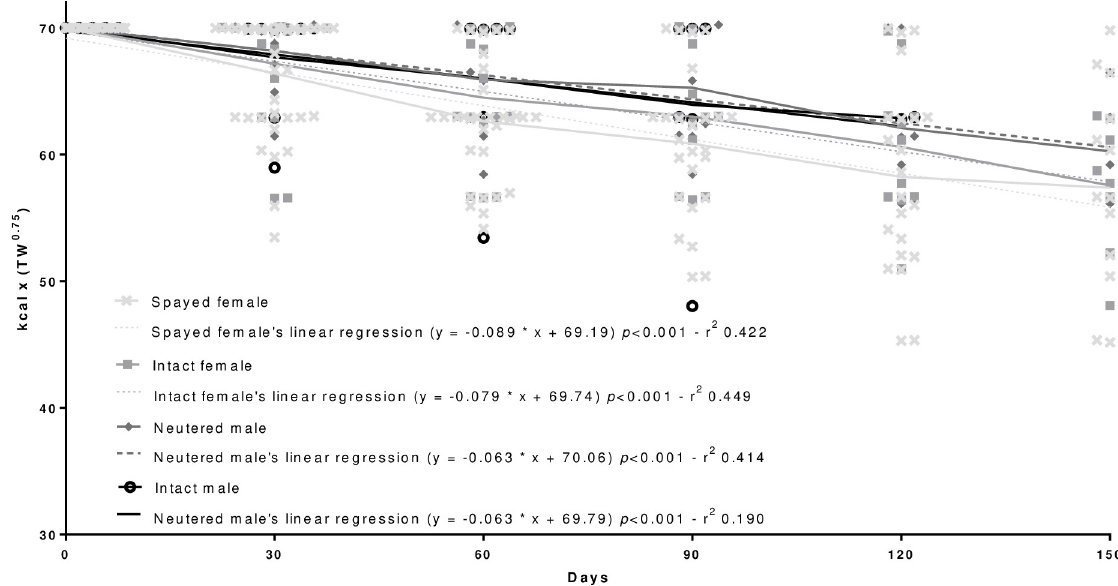
Fig 2. Regression analysis and complete distribution of the calories (kcal) applied to the weight loss equation [kcal x (TW 0.75 )] according with reproductive status.